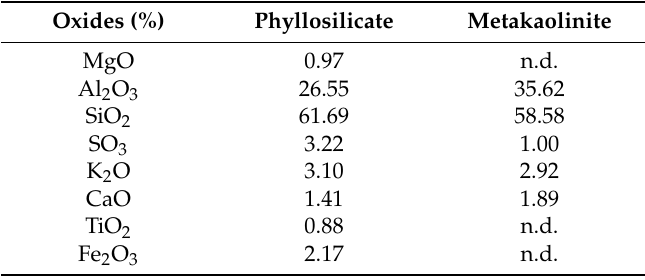
Table 7. EDX chemical analysis of the aggregates from the thermally activated coal refuse sample at 600 ◦